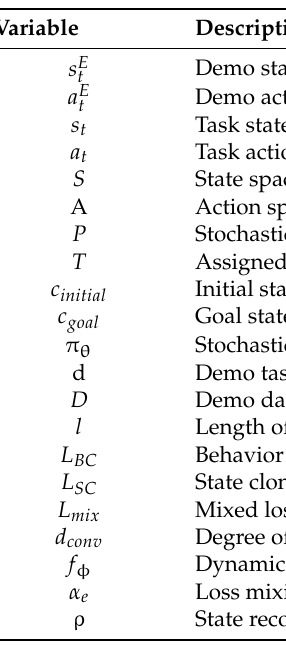
Table 1. Variable